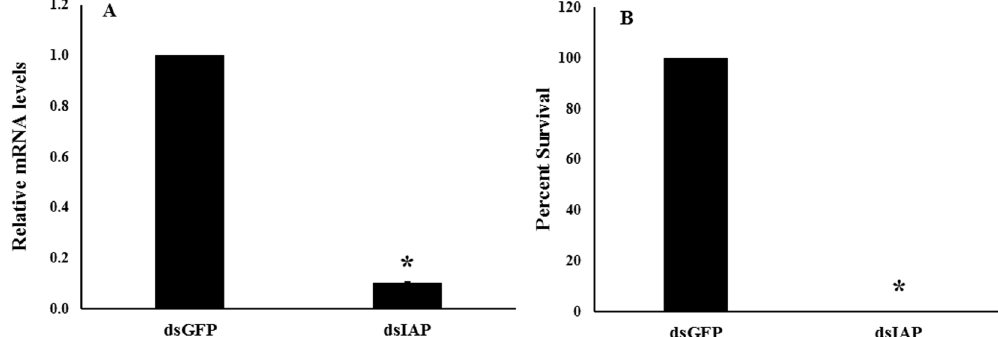
Figure 6. Relative IAP mRNA levels and mortality in adults treated with dsIAP. ( A ) Relative IAP mRNA levels in the adults. The asterisk indicates significant differences in mRNA levels (t-test, one-tailed P = < 0.001, N = 4). ( B ) Survival rate (%) on 10 th day after injection of dsRNA. The asterisk indicates significant differences in mortality between treatment and control (Fisher’s Exact test, Two-tailed, P-value < 0.001, N =